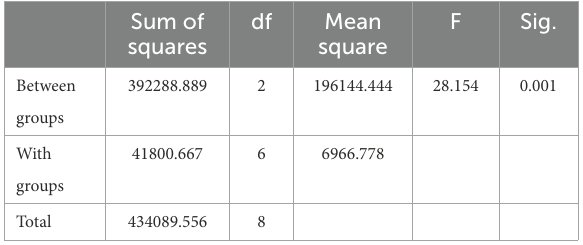
TABLE 7 The differences in the use of modality values in the three translations. Sum of df Mean F Sig. squares square